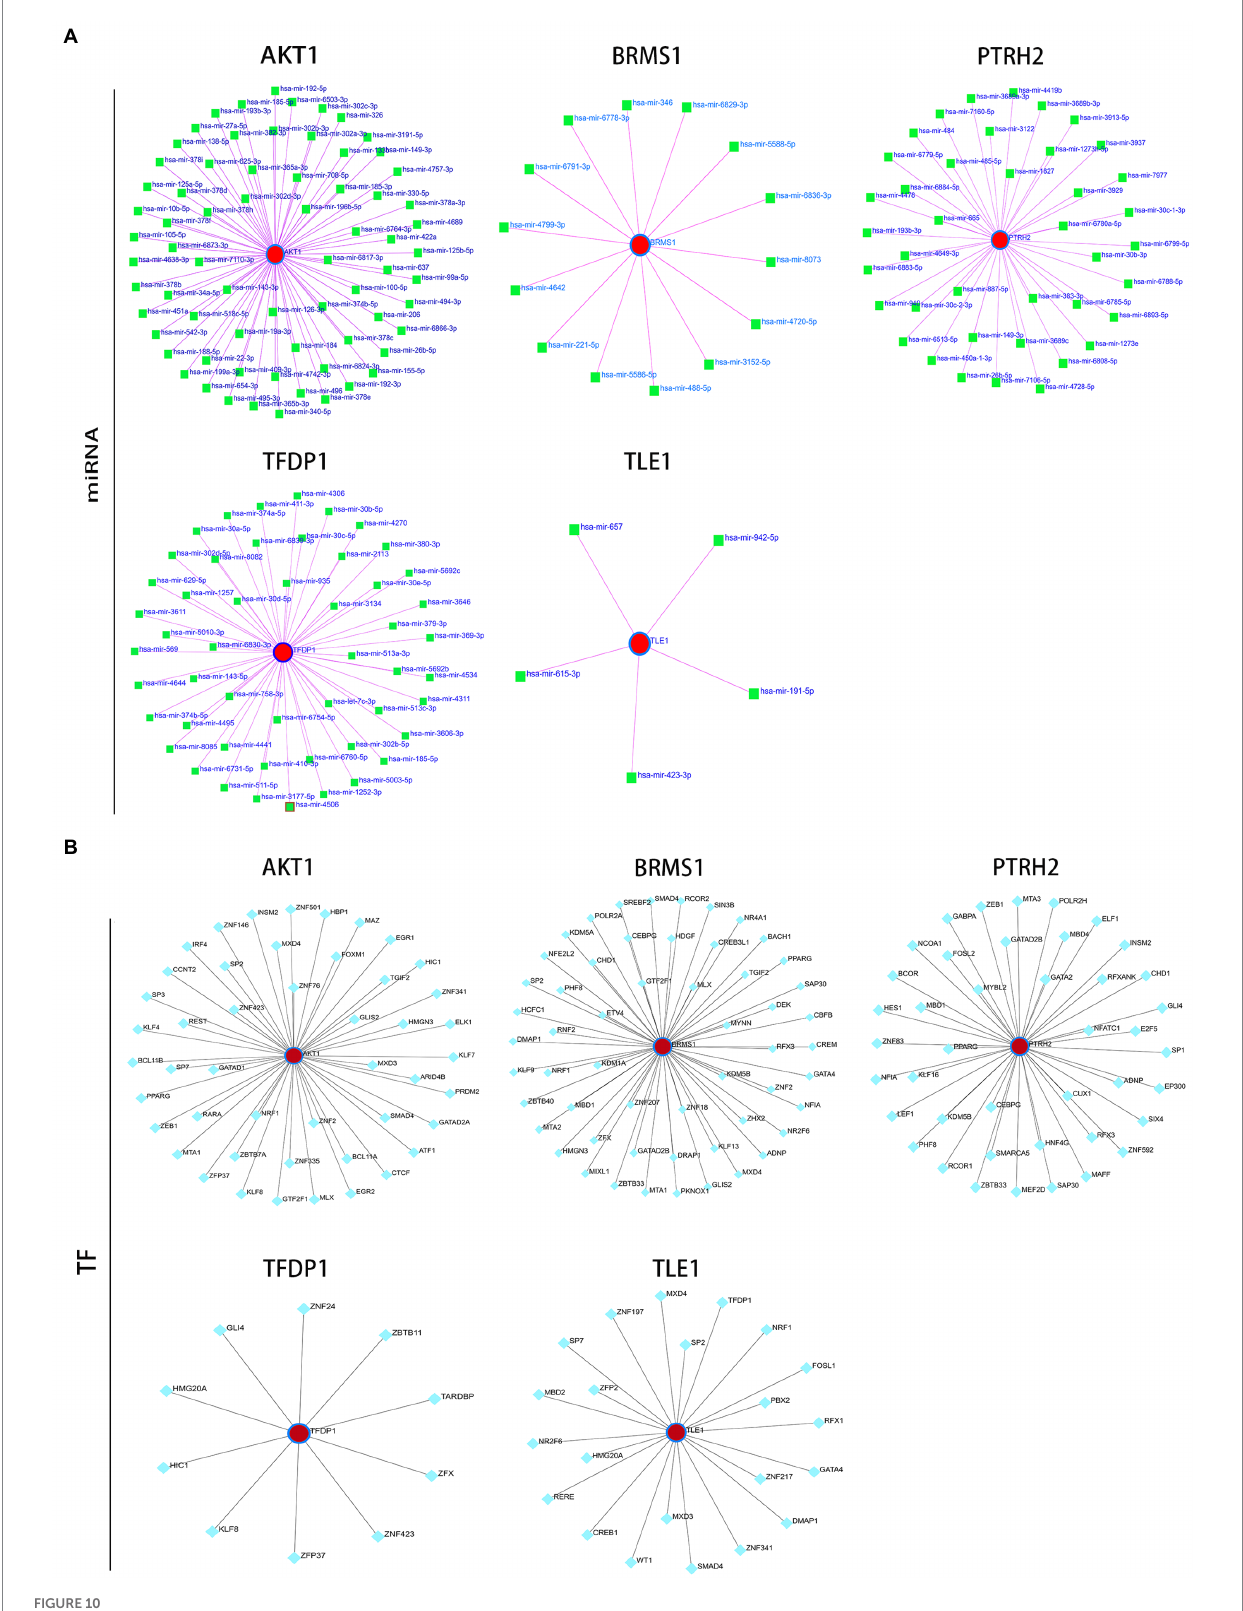
FIGURE 10 Construction of regulatory network. (A) 5 target gene-miRNA regulatory network. (B) 5 target gene-TF regulatory network. Red circle nodes represent hub genes, green squares represent miRNAs, and green-blue squares represent